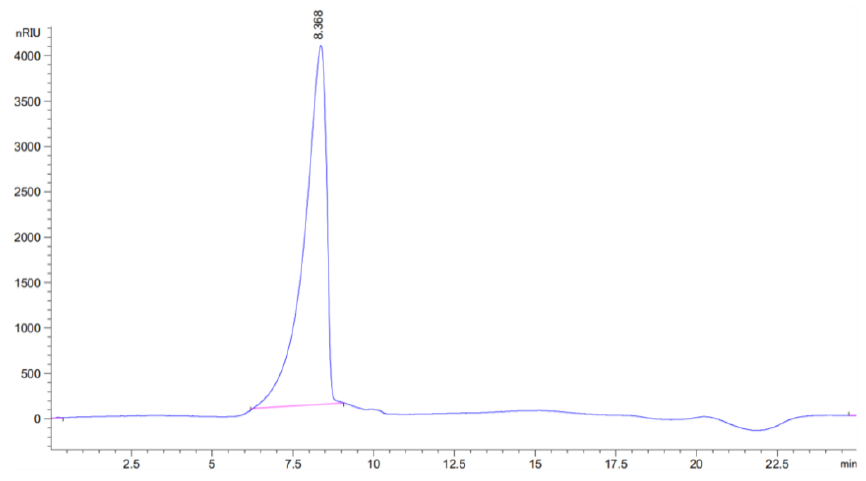
Figure 4. HPGPC chromatogram of BCP.